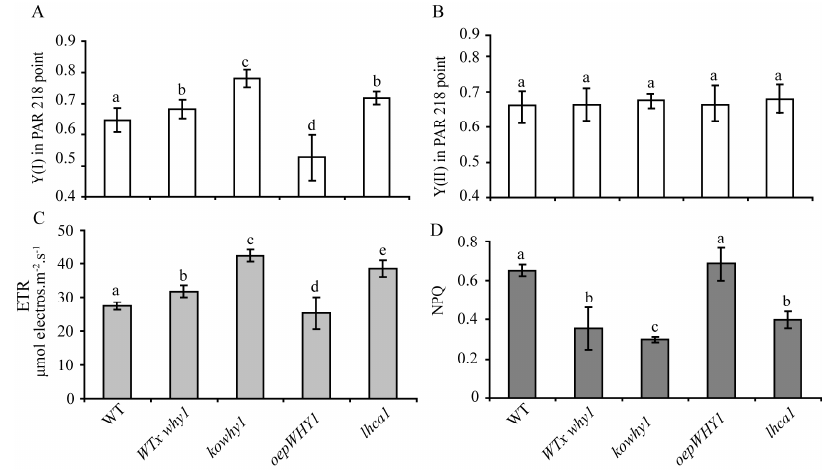
Figure 1. Analyses of the photosynthetic performance in leaves of the WHY1 , lhca1 mutants and the wild-type plants by a Dual PAM (Pulse-amplitude modulation) device. Dual PAM measurements of photochemical yield of photosystem I Y(I) ( A ), yield of photosystem II Y(II) ( B ), electron transport rate (ETR) ( C ), and photosystem II fluorescence (NPQ) ( D ), respectively. Data presented are mean ± SE ( n = 6–8). Significance analysis was performed by Tukey–Kramer method ( p < 0.05) and the data were dividing into different significance groups.